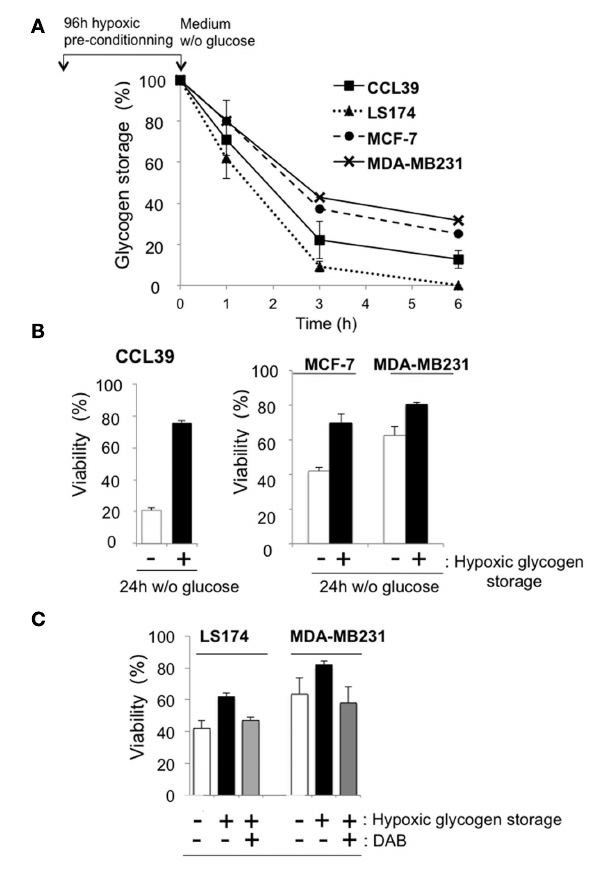
FIGURE 5 | Glycogen storage protects from cell death. (A) CCL39 ( (cid:2) ), • LS174 ( (cid:3) ), MCF-7 ( ), and MDA-MB231 (x) cells were subjected to hypoxia of 1% O 2 for 96h and then cultured in glucose-free medium for up to 6h. The glycogen concentration was measured just before removal of glucose and represents 100%. Glycogen was then measured at 1, 3, and 6h.The results are representative of at least three separate experiments. (B) Measurement of cell death in CCL39 cells. CCL39 (left panel), MCF-7, and MDA-MB231 (right panel) cells were subjected to either normoxia ( − hypoxic glycogen storage) or hypoxia ( + hypoxic glycogen storage) for 96h and incubated in glucose-free medium in hypoxia for 24h before measuring cell death. Data represent the average of at least three independent experiments. (C) Measurement of cell death in LS174 and MDA-MB231 cells in the presence of DAB. Cells were incubated in either normoxia ( − hypoxic glycogen storage) or hypoxia ( + hypoxic glycogen storage) in the presence of 1,4-dideoxy-1,4-imino-d-arabinitol (DAB) an inhibitor of glycogen phosphorylase activity. (DAB) for 96h and incubated in glucose-free medium in hypoxia for 24h before measuring cell death. Data represent the average of at least three independent experiments.